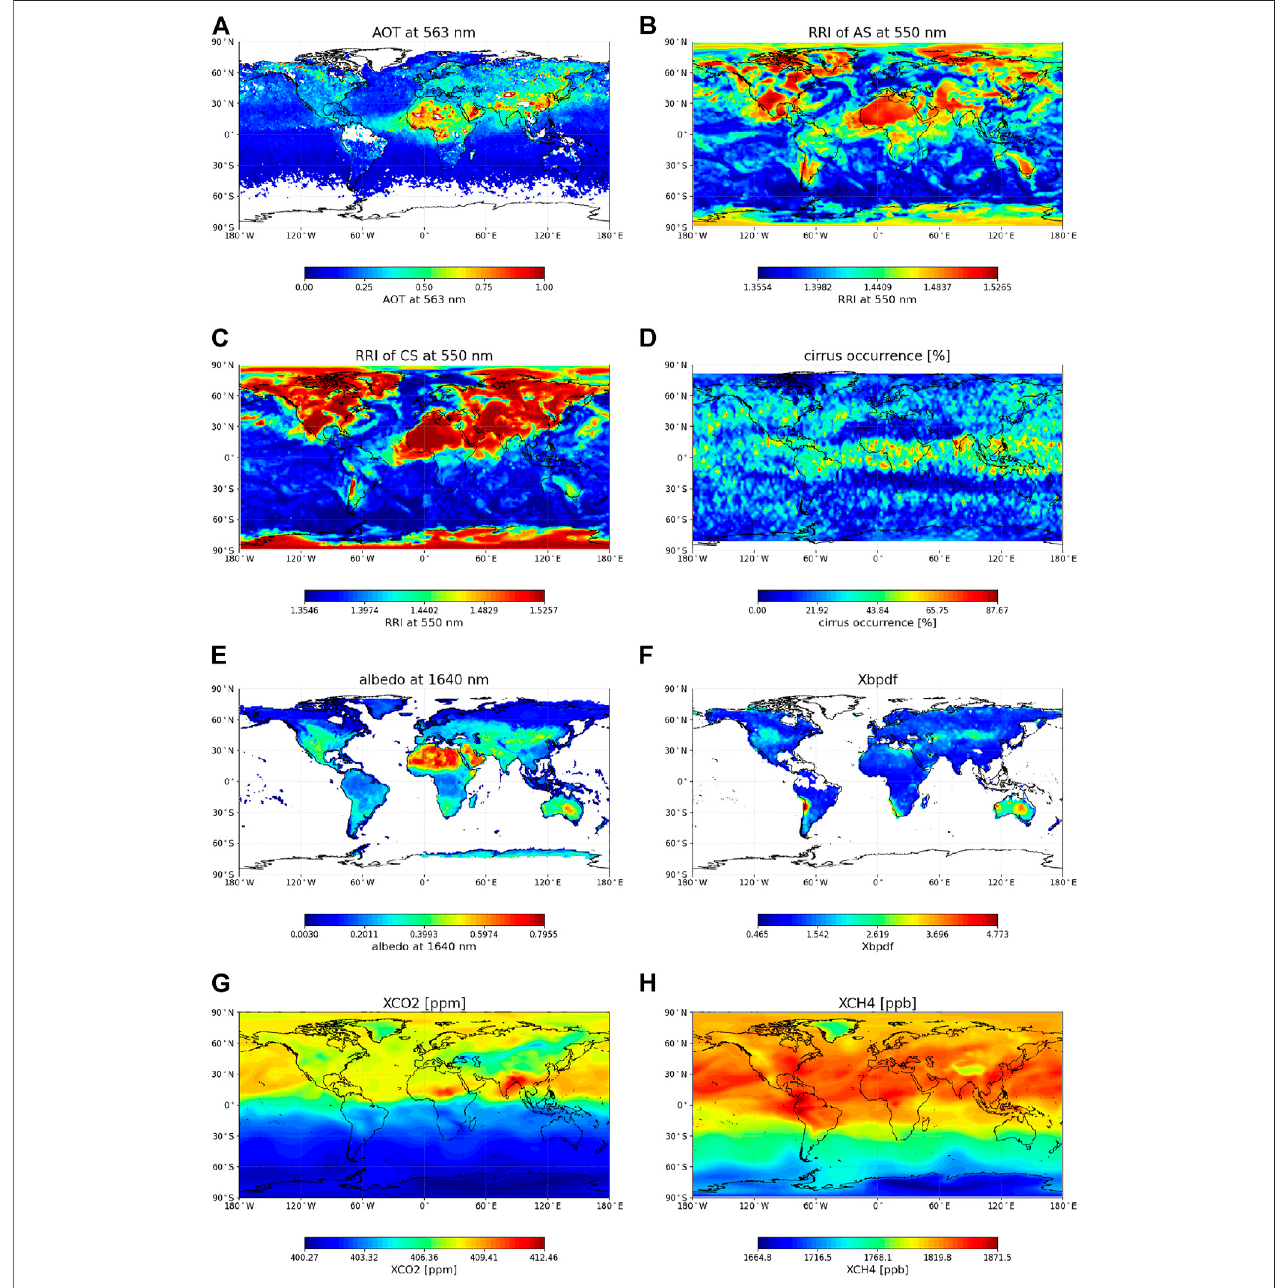
FIGURE 3 | Illustration of the ensemble data for aerosol properties (A – C) , for cirrus properties (D) , for surface properties (E, F) , and for trace gases (G, H) .